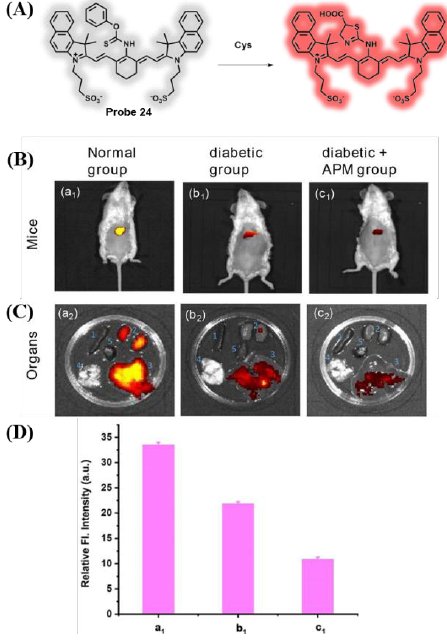
Figure 20. ( A ) Imaging mechanism of probe 24 ; ( B ) fluorescence images of mice in ( Ba 1 ) normal group, ( Bb 1 ) experimental group, and ( Bc 1 ) diabetic + APM group after treated with probe 24 ; ( C ) fluorescence images of major organs ( Ca 2 ) normal group, ( Cb 2 ) experimental group, and ( Cc 2 ) diabetic + APM group after treated with probe 24 . λ ex / em = 628/668 nm. ( D ) Relative fluorescence intensity in ( B ). Adapted from Reference [104]. Copyright 2022 Elsevier